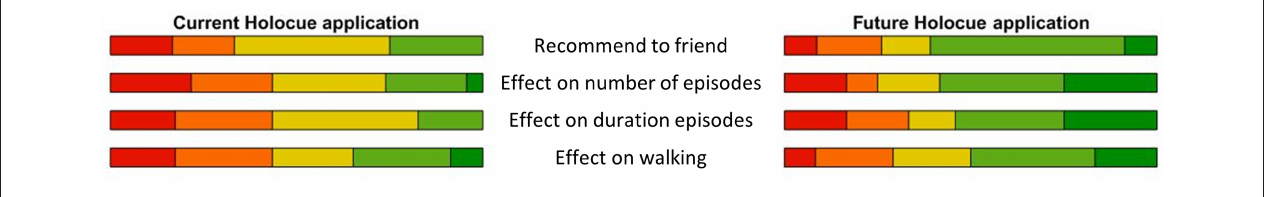
FIGURE 6 | Scores on comparable questions on the structured semi-open standardized questionnaire for the current and future Holocue application (after improvements in headset comfort and field of view). The width of the colored sections is equal to the percentage response from very negative (red) to very positive (dark green). Scores were overall more positive for the future application with anticipated improvements in headset comfort and field of view for holographic